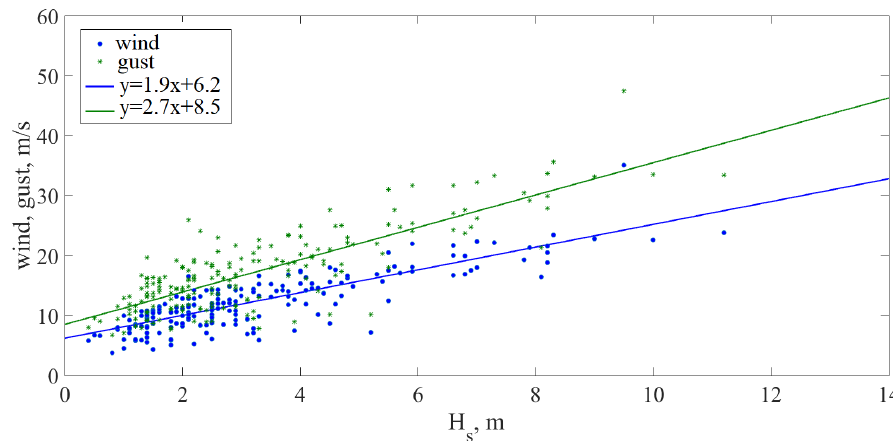
Figure 14. Dependence of wind speed and gusts on significant wave heights for deep and shallow freak wave